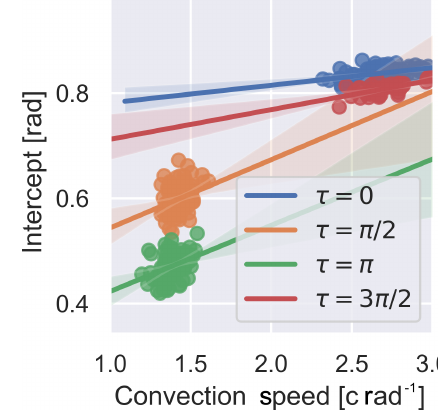
Figure 14. Relationship between the onset of shedding and convec- tion speed for a range of blowing